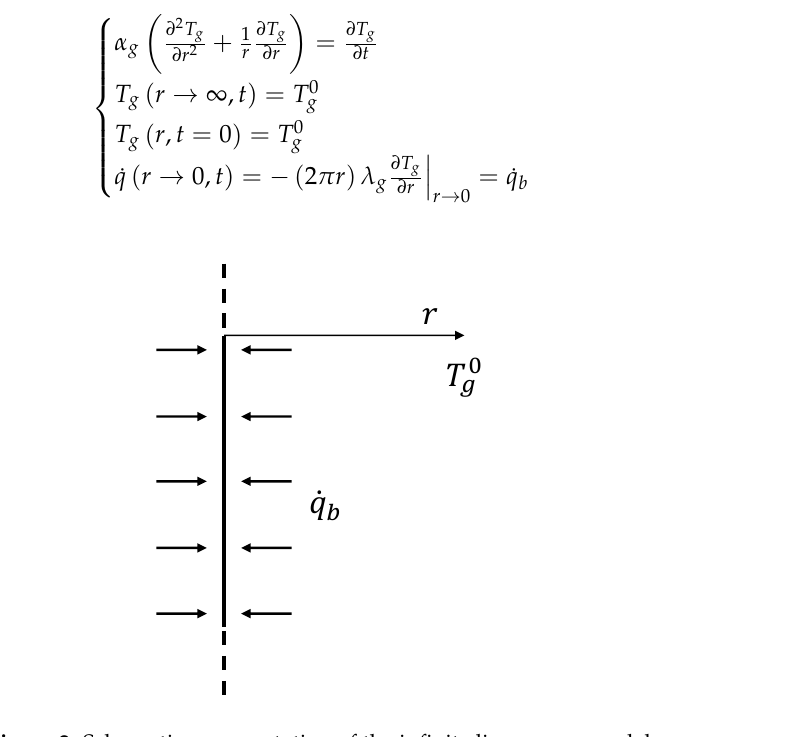
Figure 2. Schematic representation of the infinite line source